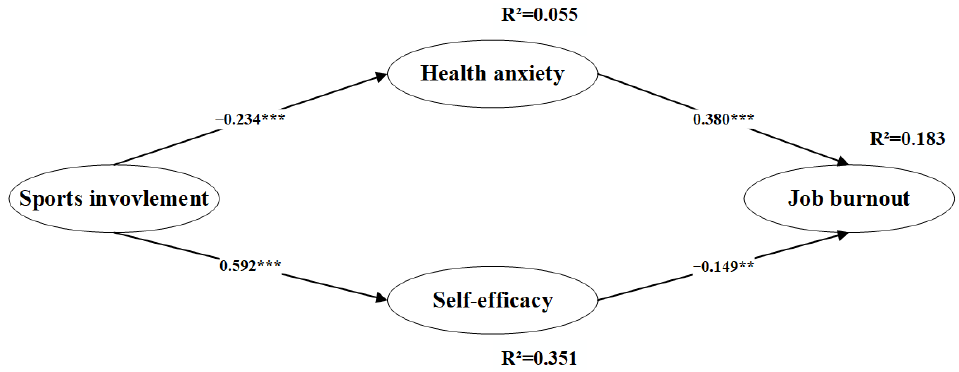
Figure 2. Structural equation modeling of the hypothesized model. ** p < 0.01, *** p < 0.001.